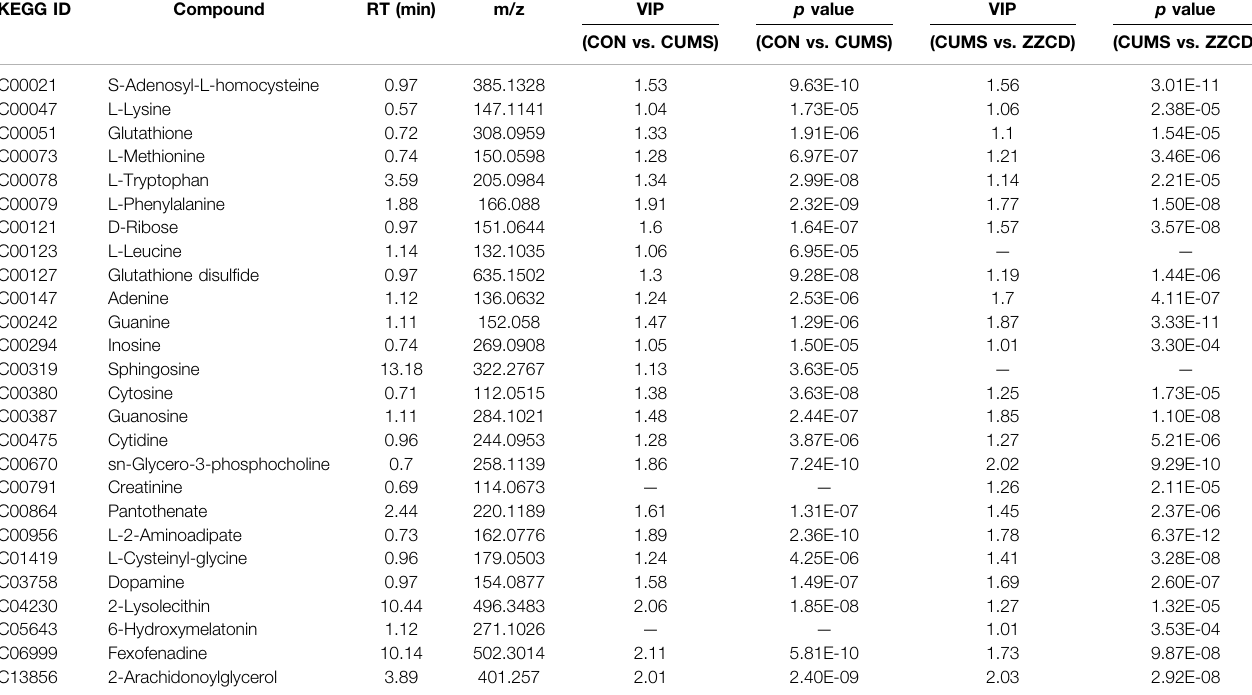
TABLE 2 | Screened differential metabolites.